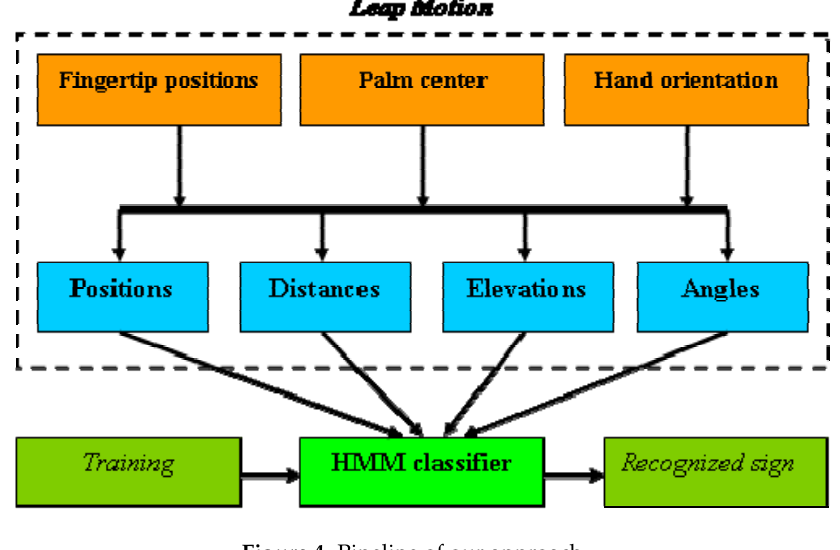
Figure 4. Pipeline of our approach.